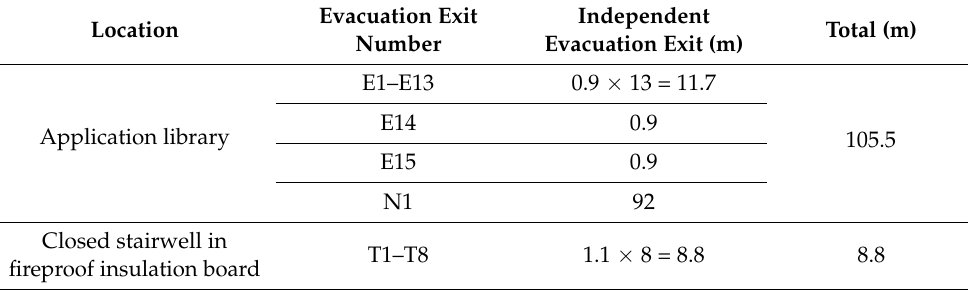
Table 8. Personnel type and composition.